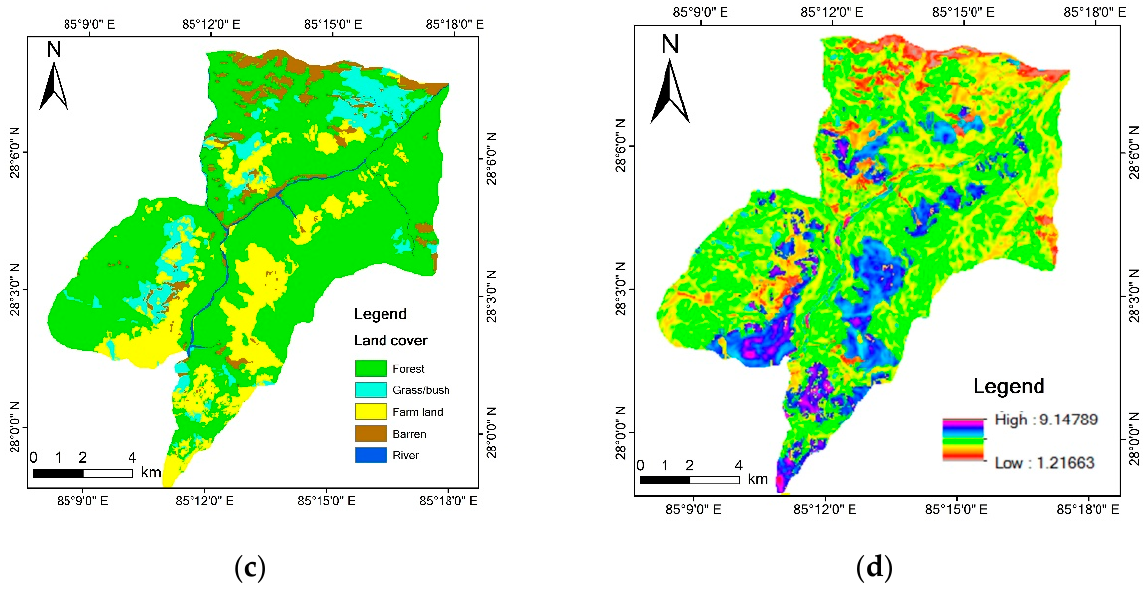
Figure 4. The base maps used in the physically based model: ( a ) digital elevation model, ( b ) landslide inventory, ( c ) land cover map, ( d ) soil depth map.